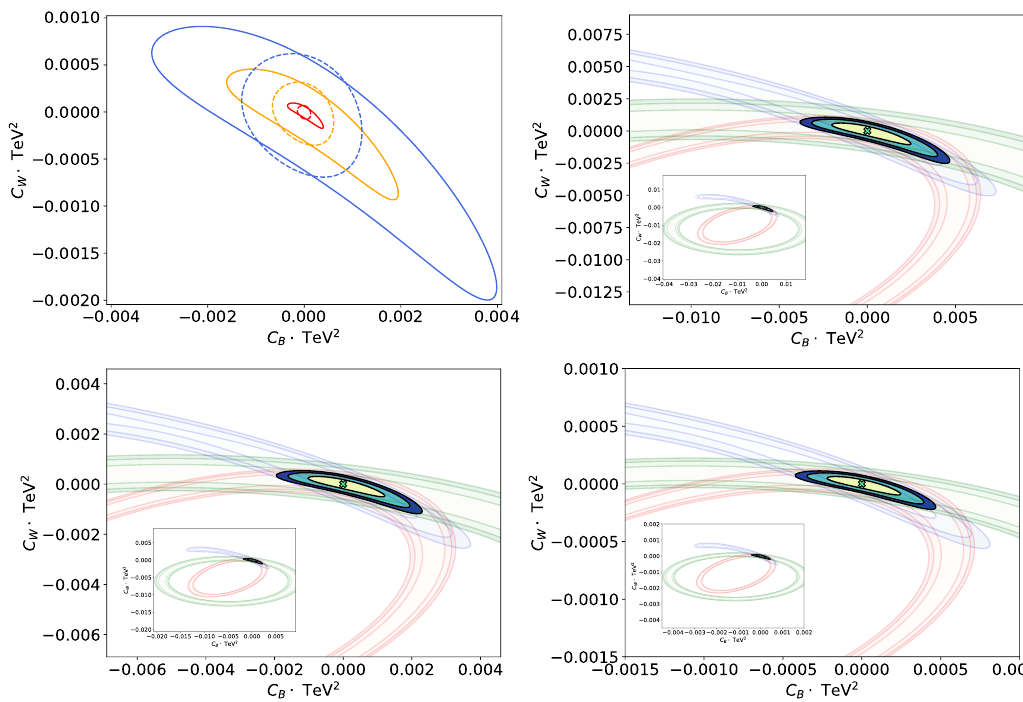
Figure 12 . Top-Left: constraints at 95% C.L. from diboson and tri-bosons production, for E cm = 10 TeV (blue), E cm = 14 TeV (orange), and E cm = 30 TeV (red), obtained from polarized inclusive Zh and fiducial WW measurements (dashed lines), and from the combination of inclusive Zh , differential WW and fiducial WWh rate with unpolarized beams (solid lines). The likelihood contours and the individual contributions to the likelihood from Zh (red), differential WW (blue) and WWh (green) are shown for each collider energy in the other